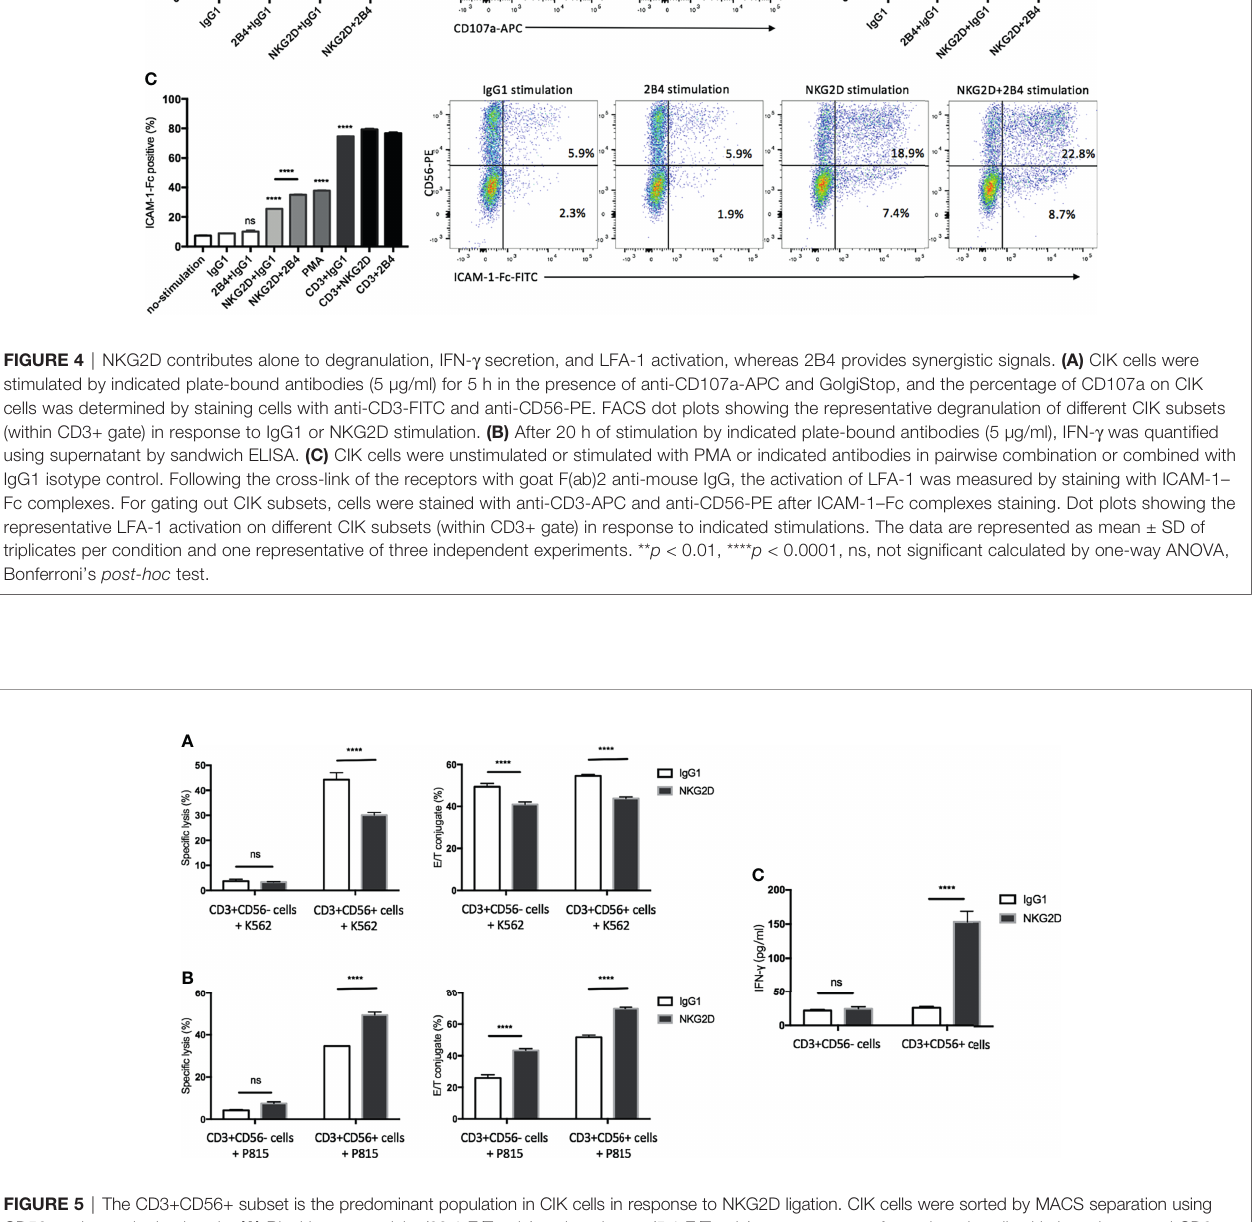
FIGURE 5 | The CD3+CD56+ subset is the predominant population in CIK cells in response to NKG2D ligation. CIK cells were sorted by MACS separation using CD56-conjugated microbeads. (A) Blocking cytotoxicity (20:1 E/T ratio) and conjugate (5:1 E/T ratio) assays were performed as described in by using sorted CD3 +CD56 − cells or CD3+CD56+ cells against K562 cells. (B) Redirected cytotoxicity (20:1 E/T ratio) and conjugate (5:1 E/T ratio) assays were performed as described in by using sorted CD3+CD56 − cells or CD3+CD56+ cells against antibody-loaded P815 cells (5 µg/ml). (C) After 20 h of stimulation by indicated plate-bound antibodies (5 µg/ml), IFN- g produced by CD3+CD56 − cells or CD3+CD56+ cells was quanti fi ed using supernatant by sandwich ELISA. The data are represented as mean ± SD of triplicates per condition and one representative of three independent experiments. **** p < 0.0001, ns, not signi fi cant calculated by two-way ANOVA, Bonferroni ’ s post-hoc test.